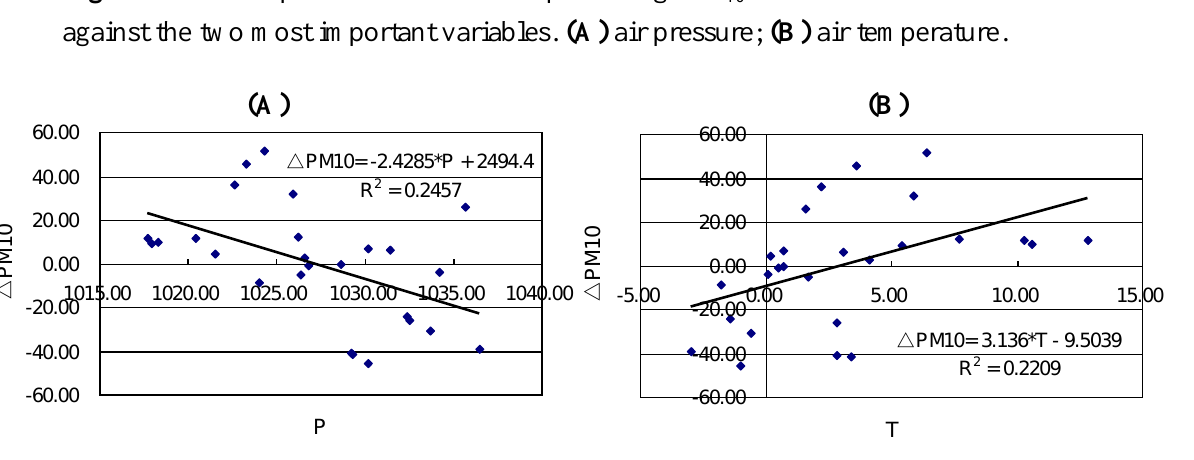
from AOT in the winter season 10